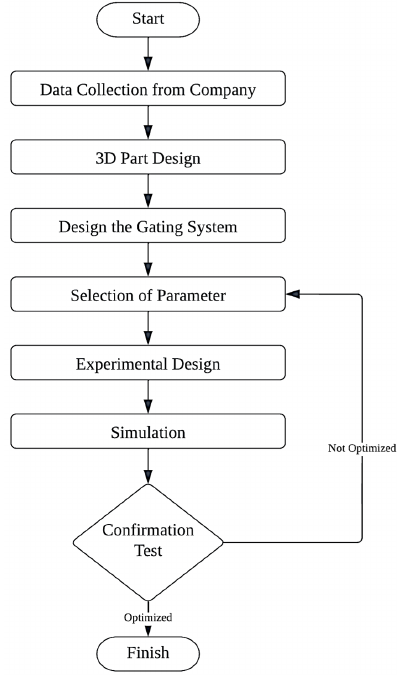
Figure 1. Procedure and Methodology Adopted for the Study .